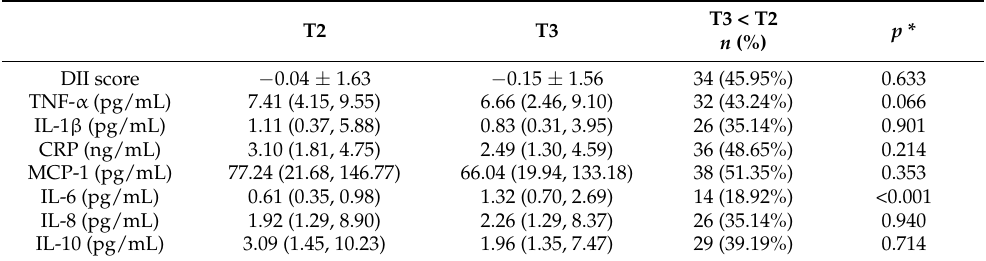
Table 4. Concentrations of cytokines in pregnant women with repeated measurements ( n = 74).